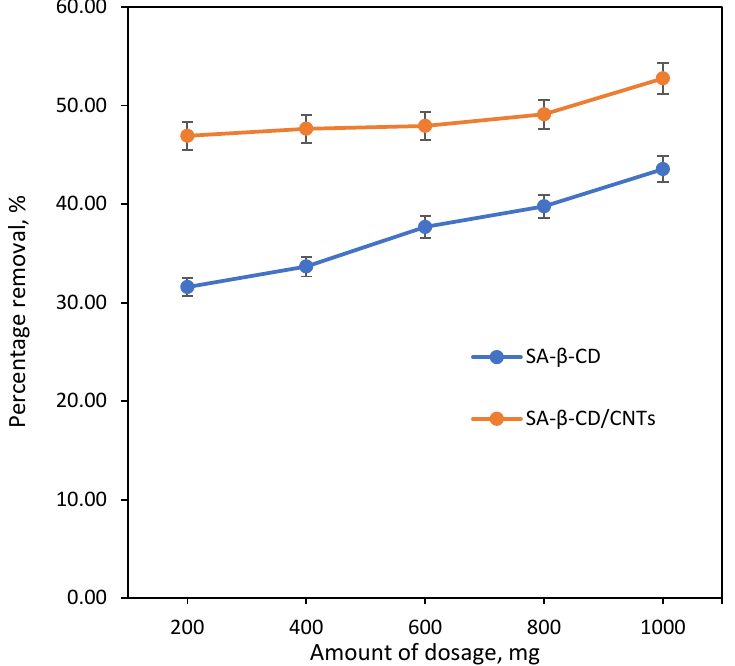
Figure 7 . Effect of dosage condition: [Ni(II)] = 10 mg/L, pH = 4, contact time= 60 min . Figure 7. Effect of dosage condition: [Ni(II)] = 10 mg/L, pH = 4, contact time = 60